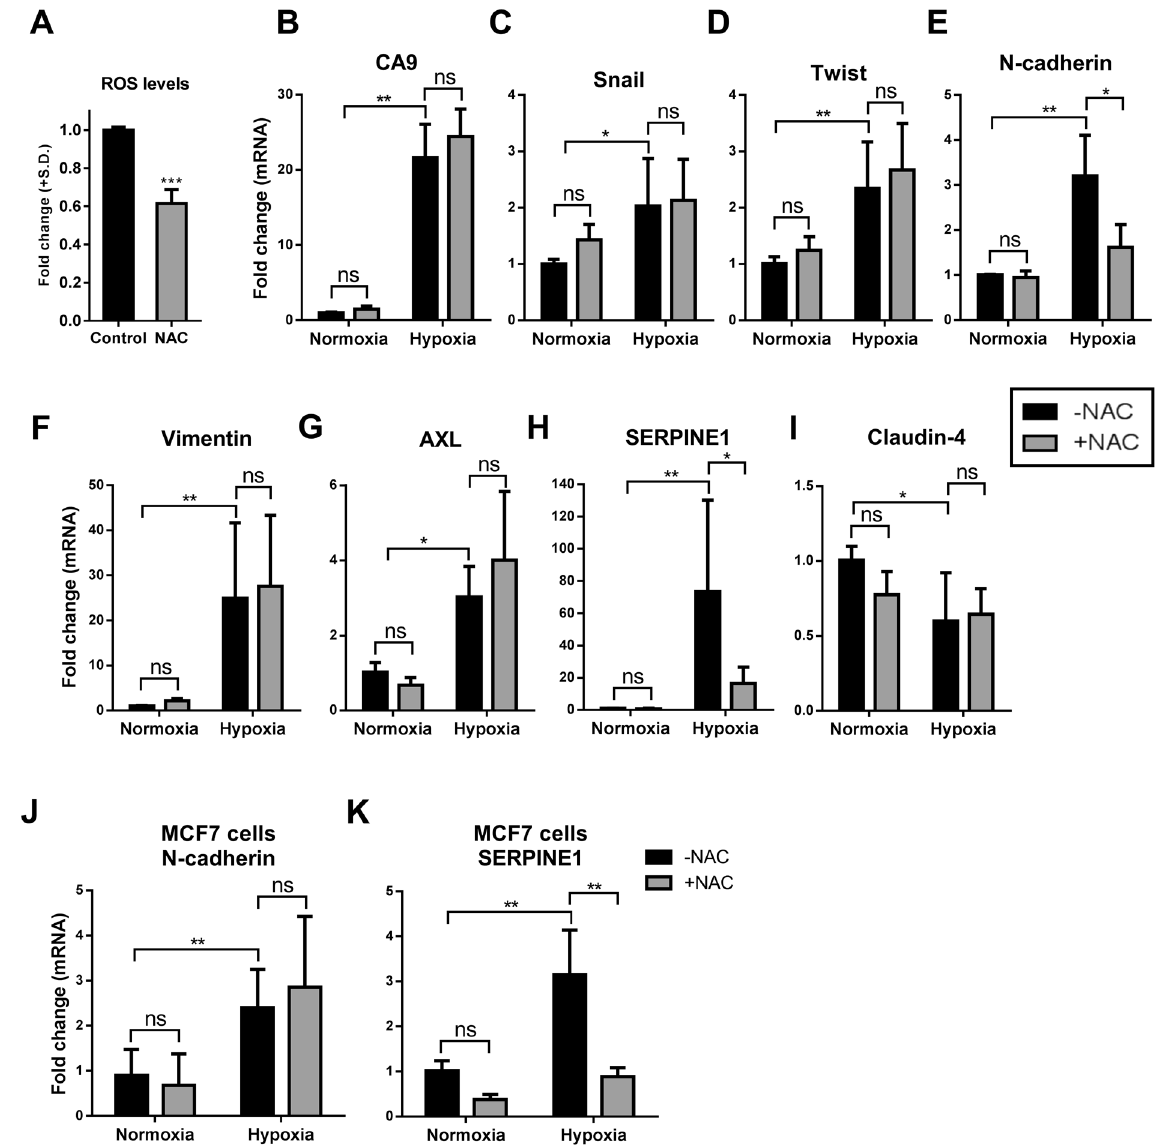
Figure 2. The effect of NAC treatment on mRNA levels of a panel of genes associated with EMT and hypoxic responses. ( A ) Intracellular levels of ROS measured by DCF-DA assay in cells exposed to hypoxia (12 h) in the presence and absence of NAC (10 mM). Graph represents the mean ± SD relative to the control (hypoxia with no NAC) for three independent experiments. *** p < 0.0001 (unpaired t-test). Post serum-reduction MDA-MB-468 breast cancer cells were treated with or without NAC (10 mM) and exposed to hypoxia for 24 h. The effect of NAC on ( B ) CA9, ( C ) Snail, ( D ) Twist, ( E ) N-cadherin, ( F ) vimentin, ( G ) AXL, ( H ) SERPINE1 and claudin-4 ( I ) was assessed using real time RT-PCR. ns = not significant ( p > 0.05), * p < 0.05, ** p < 0.01 (two- way ANOVA, with Tukey’s multiple comparisons test). Graphs represent the mean ± SD for three independent experiments. The effect of NAC on the expression of ( J ) N-cadherin and ( K ) SERPINE1 in hypoxia and control normoxia was assessed using real time RT-PCR. ns = not significant ( p > 0.05), ** p < 0.01 (two-way ANOVA, with Tukey’s multiple comparisons test). Graphs represent the mean ± SD for three independent